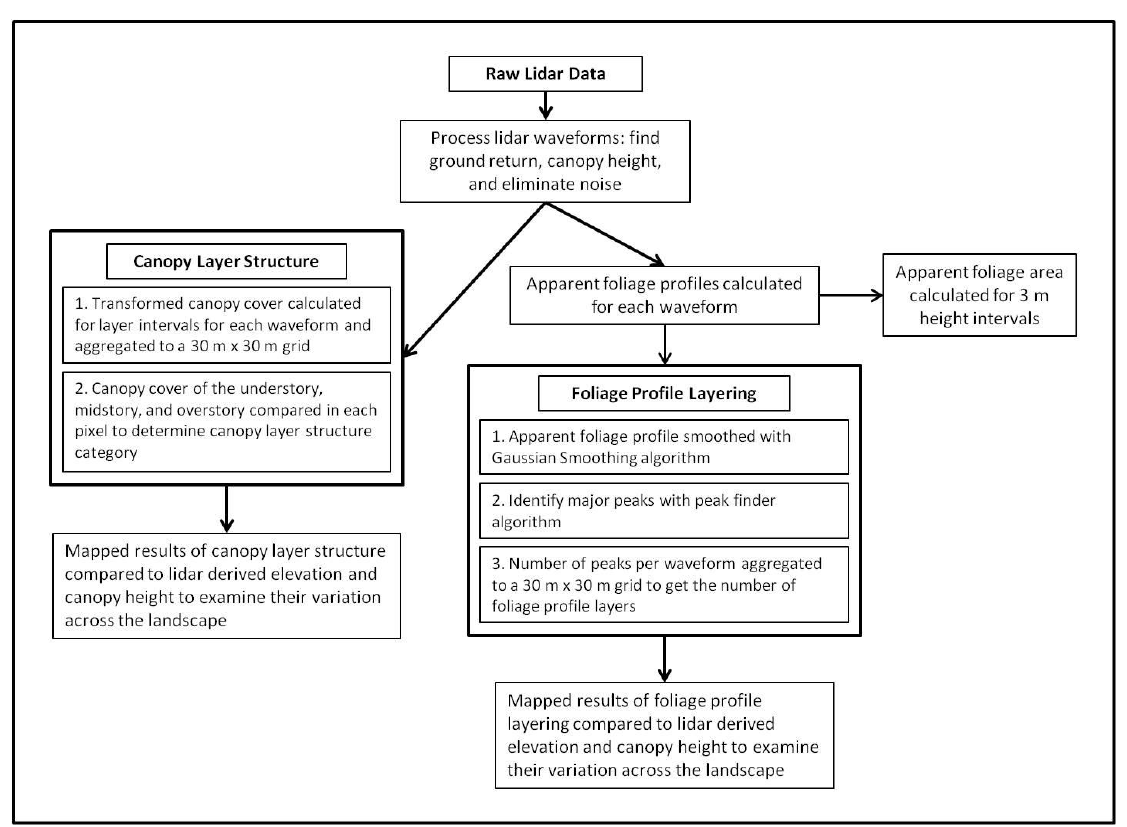
Figure 1. Flowchart of lidar processing and